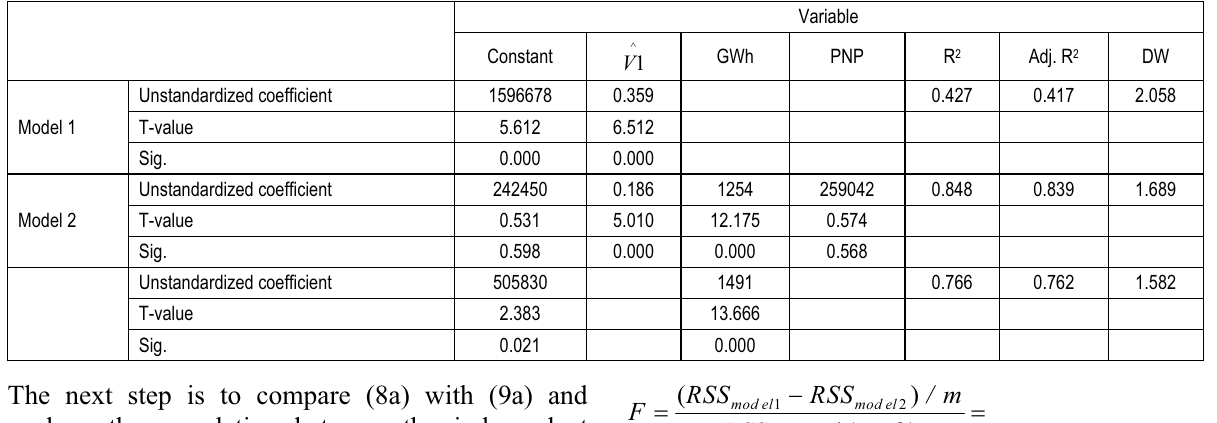
Table 4. Regression estimation based on different independent variables